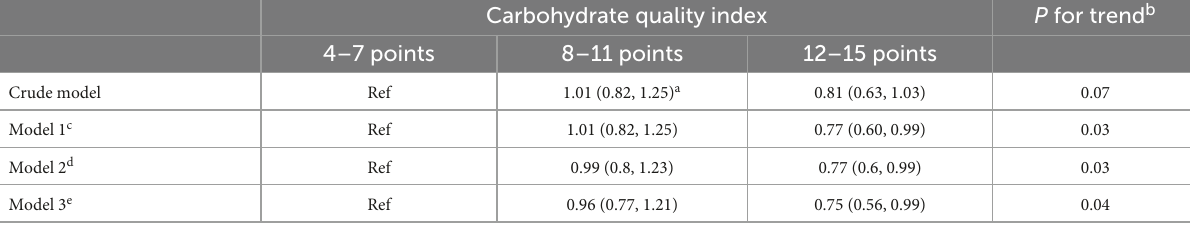
TABLE 3 Associations between pre-pregnancy CQI and GDM.